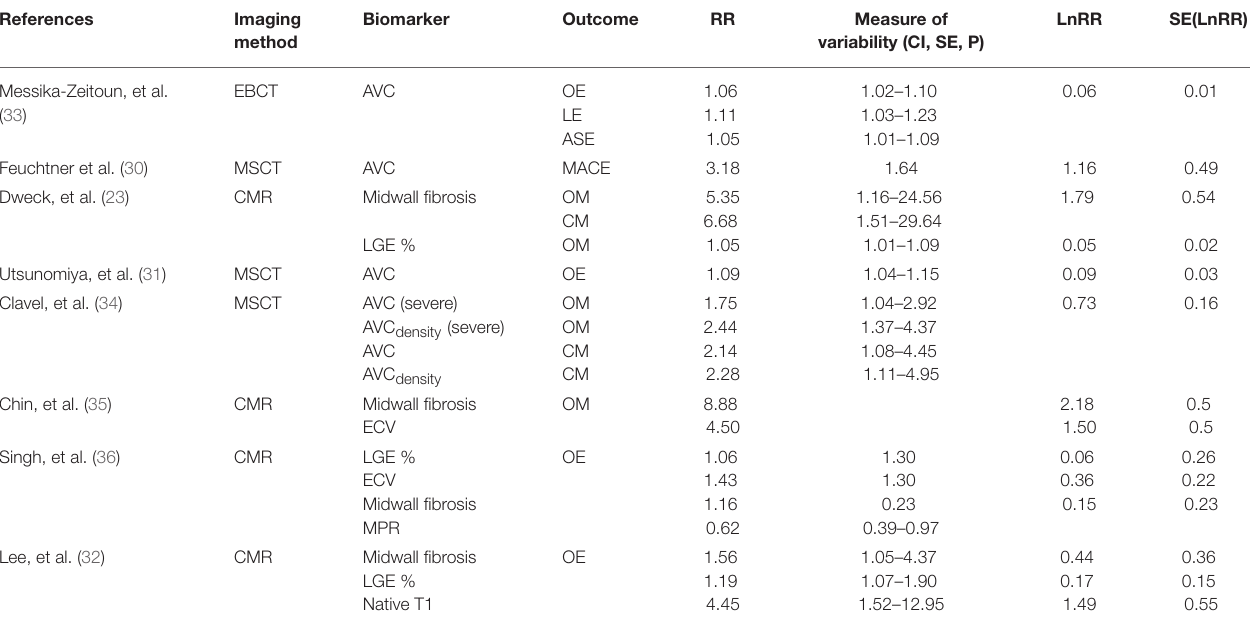
TABLE 2 | Associations between imaging biomarkers, effect size (Variability), and outcomes in